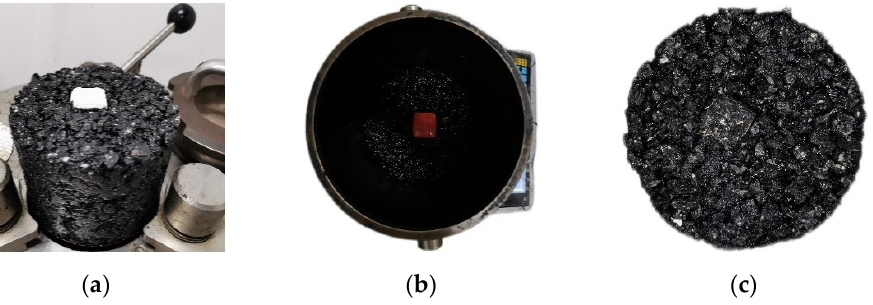
Figure 6. SmartRock embedded in SAM 13 mixture specimen: ( a ) top, ( b ) center, and ( c ) bottom.